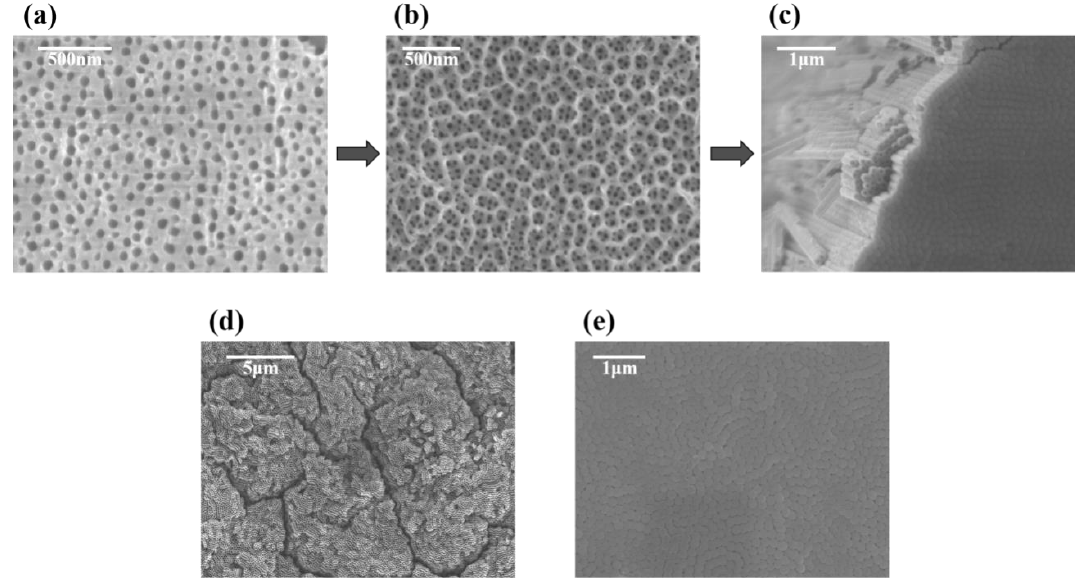
Figure 3. SEM images showing growth process of TiO 2 nanotube array: ( a ) pits formed on the oxide layer; ( b ) conversion of pits to nanopores; ( c ) conversion of nanopores to nanotubes; ( d ) the top view of the nanotube array; ( e ) the bottom view of the nanotube array.